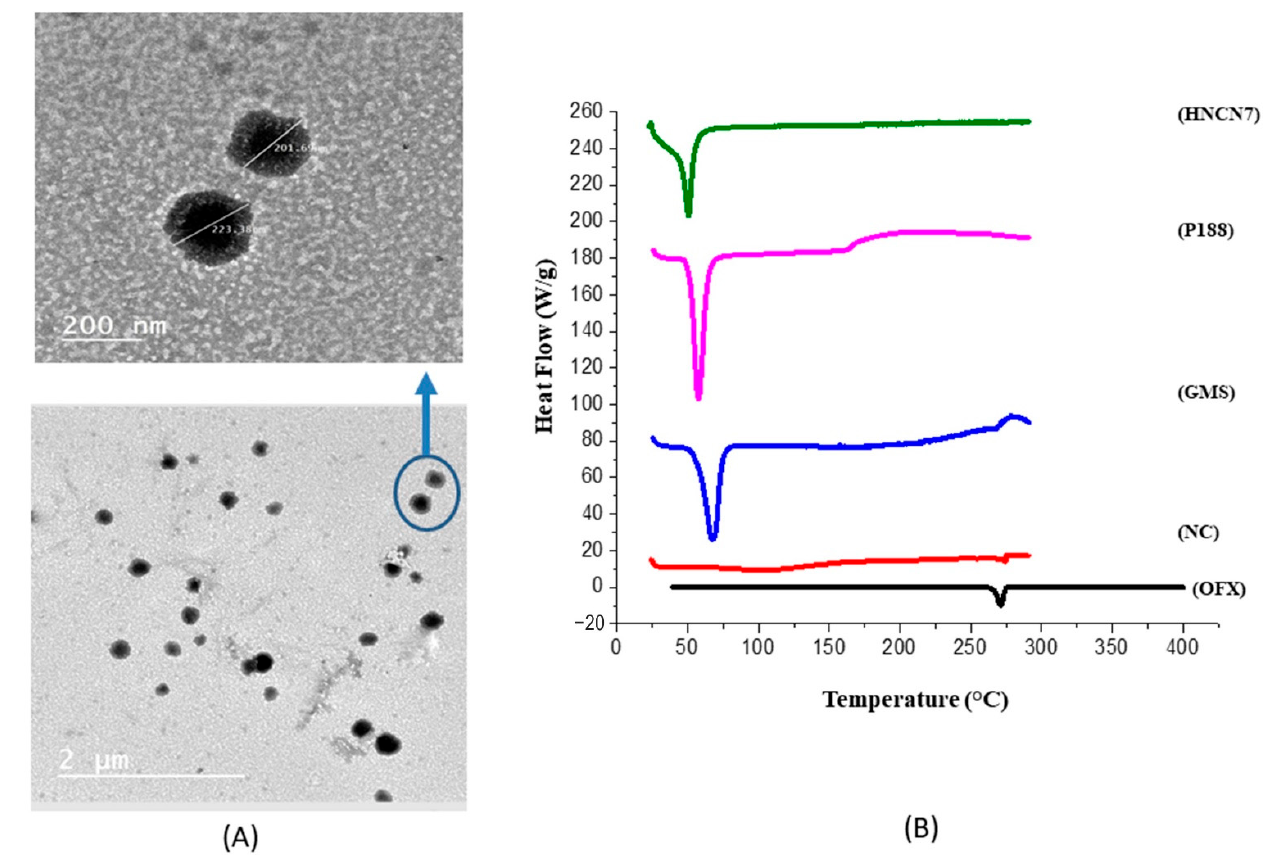
Figure 3. ( A ) Transmission electron micrographs (TEM) of the optimum formula HNCN7, ( B ) DSC thermograms of ofloxacin (OFX), nanocellulose crystals (NC), glyceryl monostearate (GMS), polox- amer 188 (P188) and the optimum formula